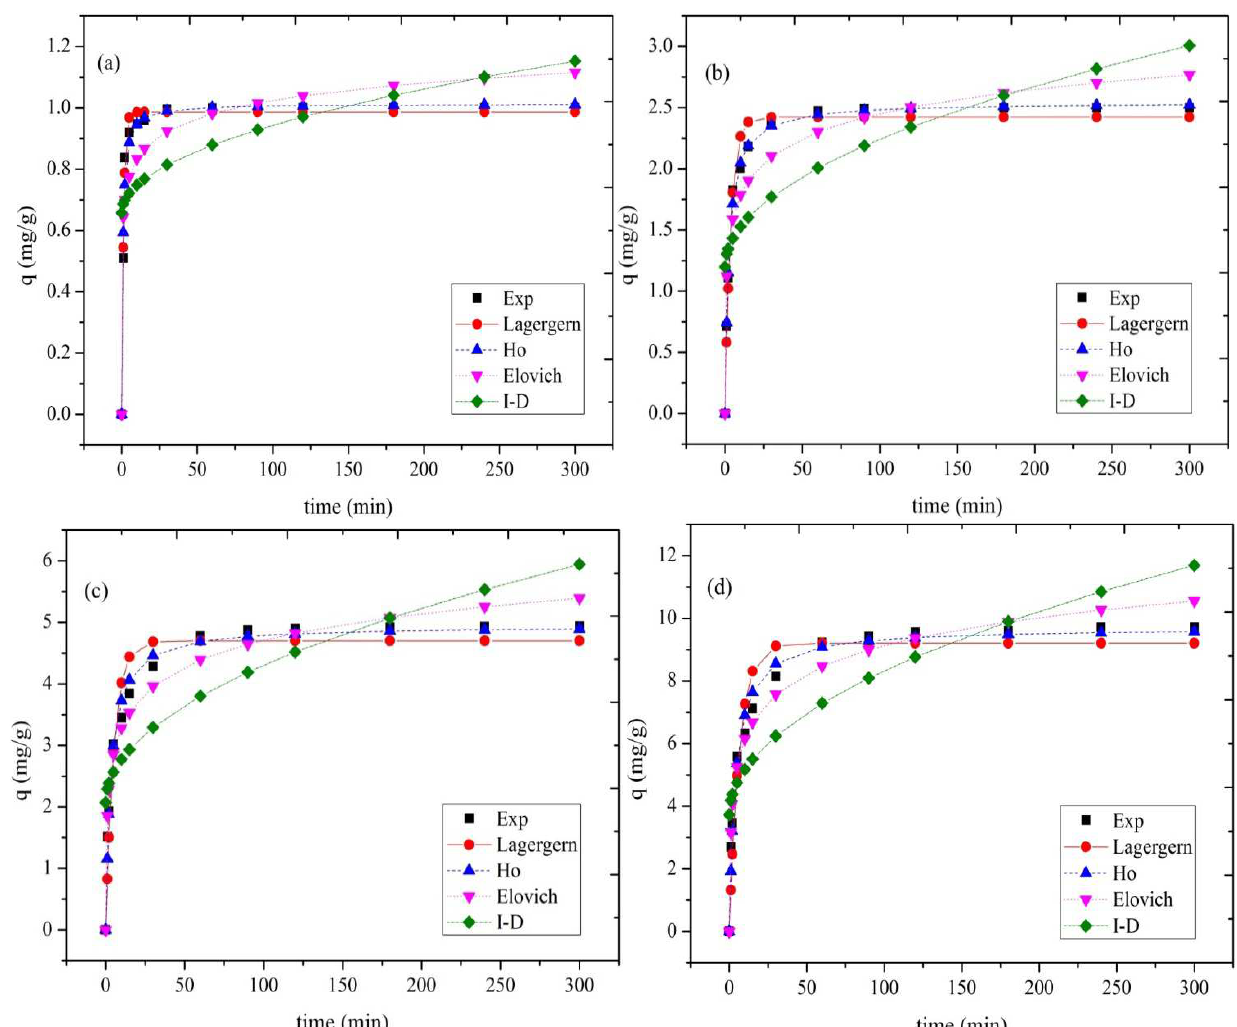
Figure 4. Non-linear kinetic plot of MB adsorption onto AAST surfaces at different initial MB concentrations (a: 10, b: 25, c: 50, and d: 100 mgl -1